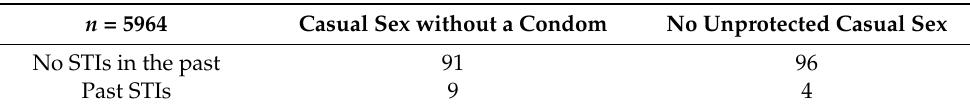
Table 7. Past STIs depending on casual sex without a condom. All data contained in the table are presented as a